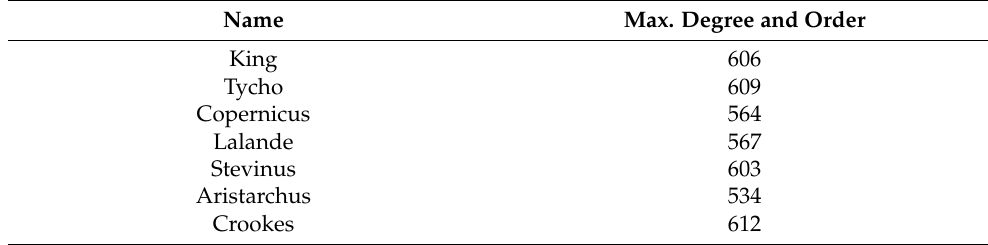
Table 3. Maximum degree and order to minimize the